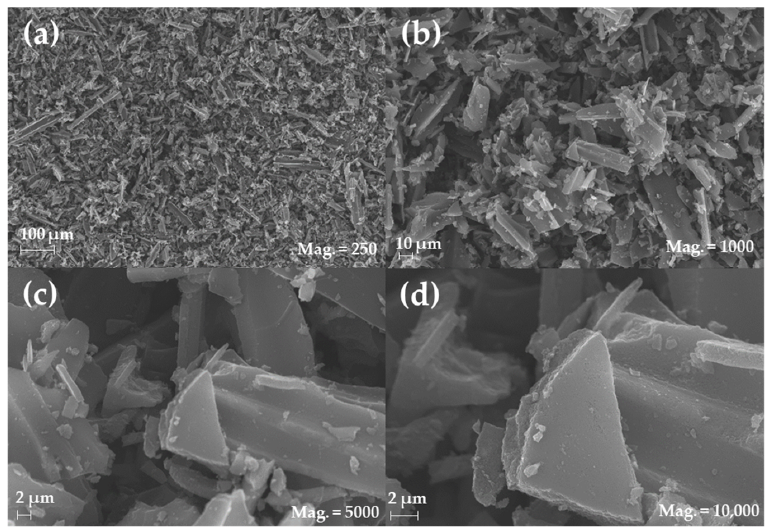
Figure 2. SEM images of 5% Pt/C in magnifications from 250 to 10,000, ( a – d ). All images were taken with following parameters: EHT = 20.0 kV, WD = 8.5 mm, SingalA = InLens. For the Ru/C, the SEM images stand in contrast to the particles described